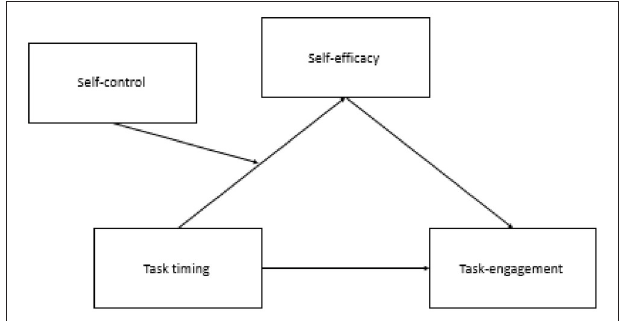
FIGURE 1 | Self-efficacy mediates the effect of task timing (near future or distant future) on task engagement for different levels of